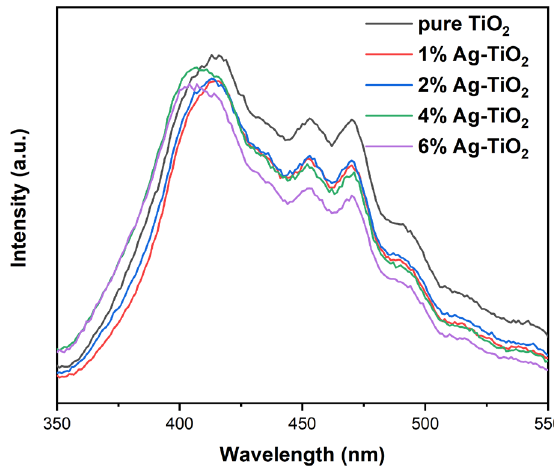
Figure 7. Photoluminescence (PL) spectra of pure TiO 2 and Ag-TiO 2 .